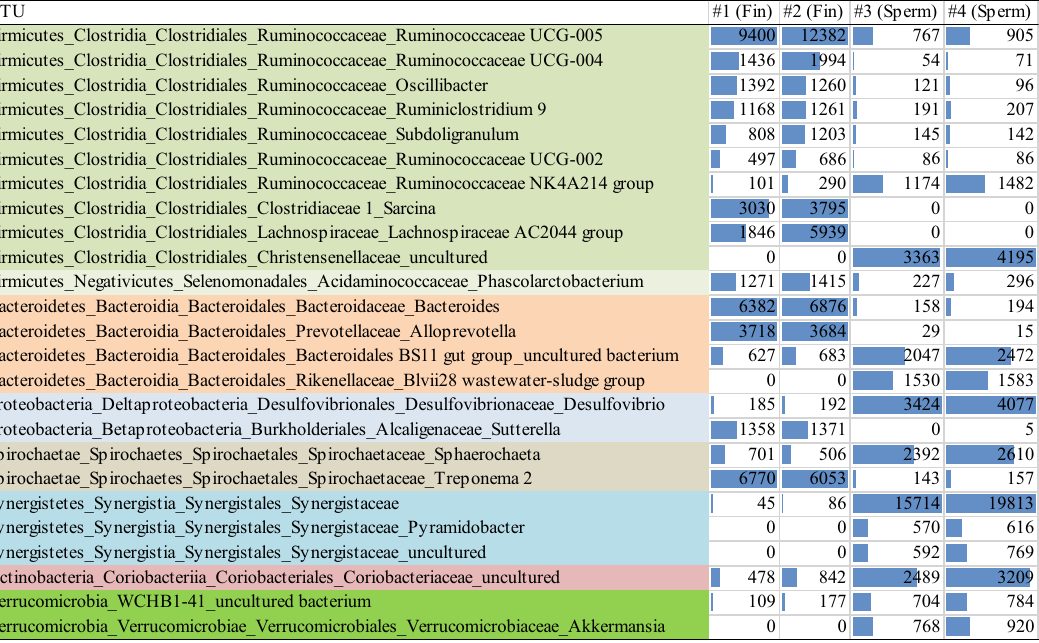
Figure 4. Genus level classification of the most representative (> 0.1% of total reads) and significantly different (Kruskal–Wallis, p < 0.05) OTUs found among the two whale species sampled. Different colours represent the different phyla; Histogram bars represent the abundance level of each OTU (quartile